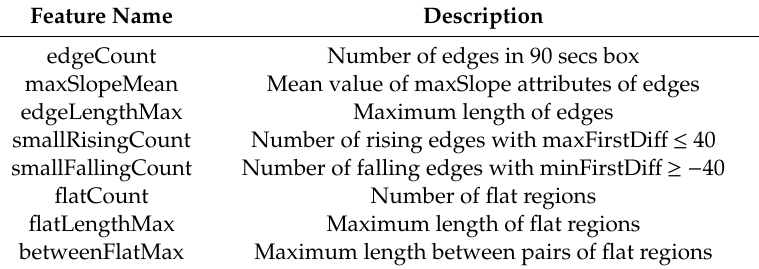
Table 4. List of Table 4. List of Features.